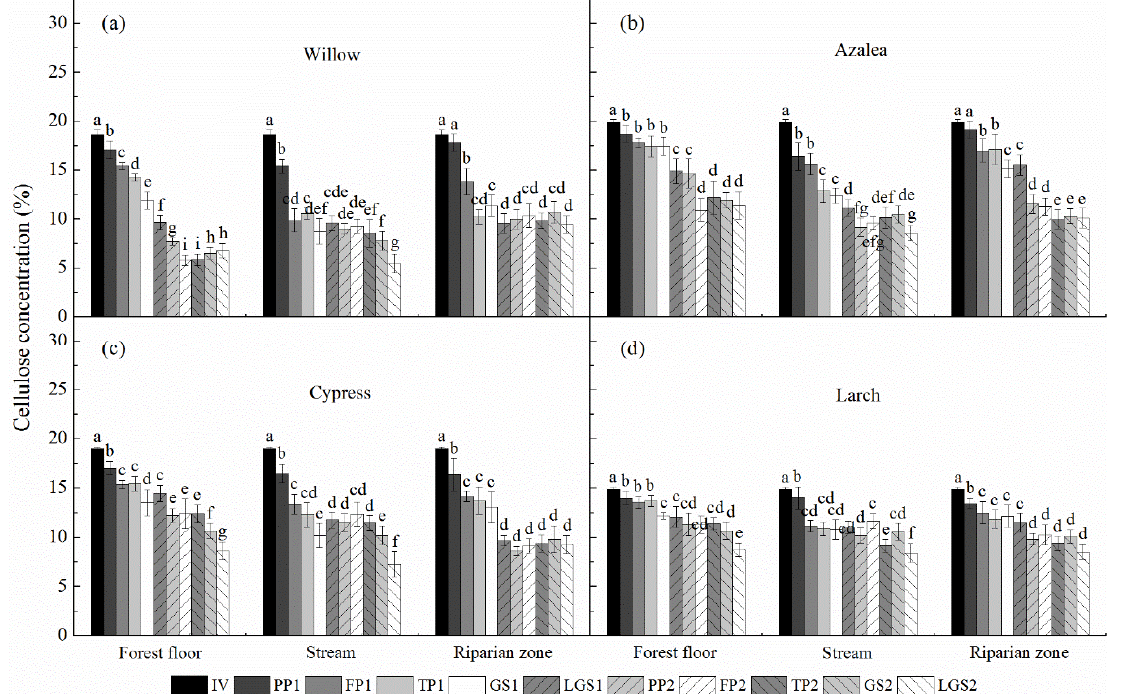
Figure 2. Dynamics of cellulose concentration (%) in decomposing foliar litter of ( a ) willow; ( b ) azalea; ( c ) cypress; and ( d ) larch in different ecosystem types during the two-year experiment (mean ± SD, n = 9). Different lowercase letters indicate statistically significant ( p < 0.05) differences of cellulose concentration among different decomposition periods for a given litter species in a specific type of ecosystem. IV: initial value; PP: pre-freezing period; FP: freezing period; TP: thawing period; GS: growing season; LGS: late growing season; 1: the first year; 2: the second